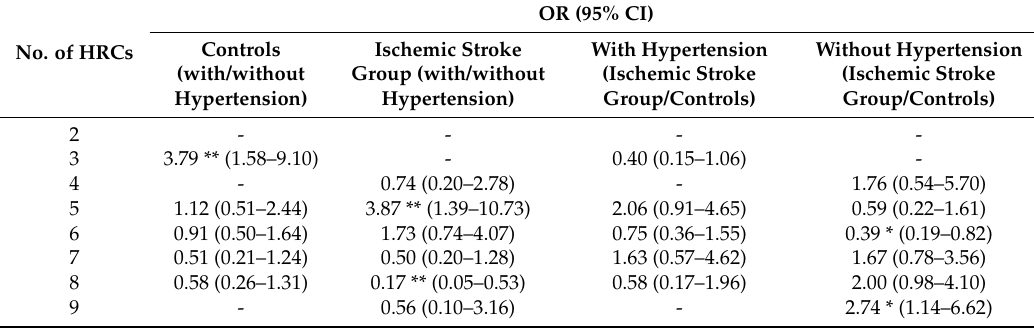
Table 4. Association between frequencies of homozygous recessive characteristics regarding the presence of ischemic stroke and hypertension.